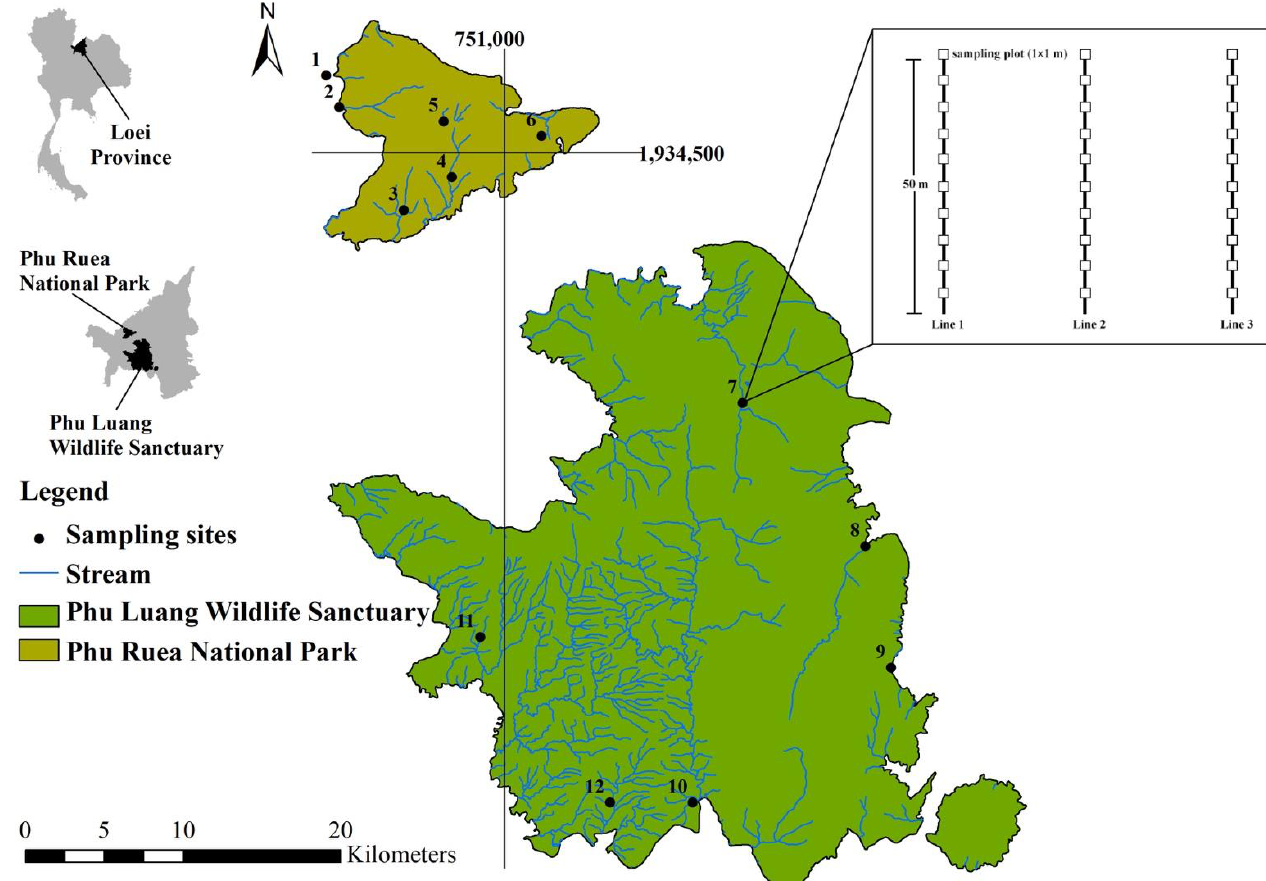
Table 1. Physical characteristics of the streams and the weather in Phu Luang Wildlife Sanctuary (PL) and Phu Ruea National Park (PR) between February 2018 and January 2019.